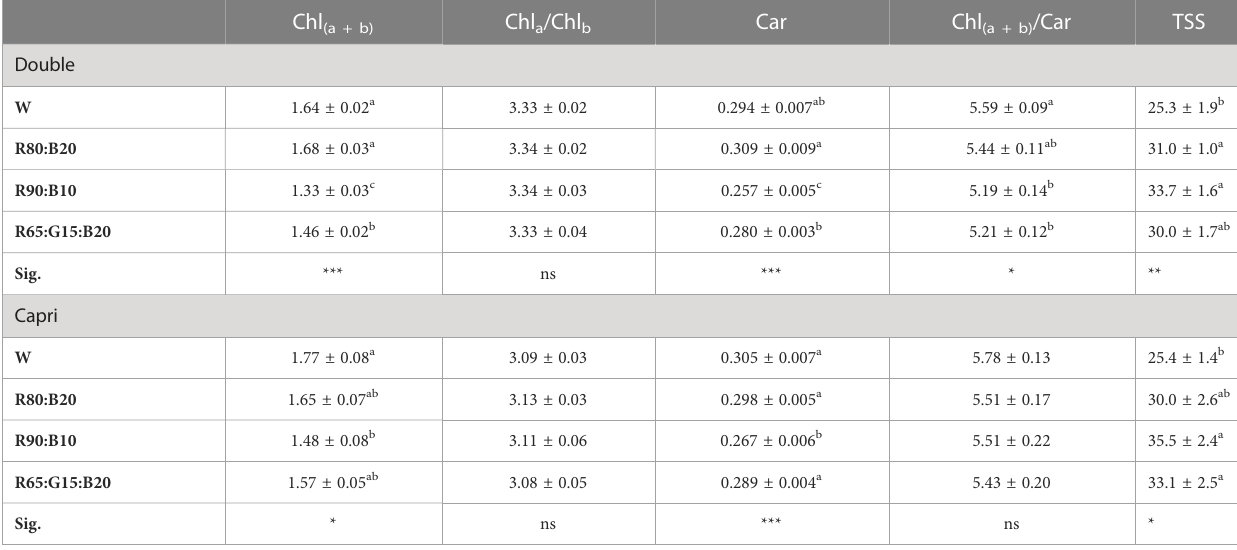
TABLE 4 Foliar photosynthetic pigments concentration (mg mg − 1 FW), total chlorophyll (Chl (a + b) ), chlorophyll a/b ratio (Chl a /Chl b ), total carotenoids (CAR) and Chl (a + b) /Car, and total soluble sugars concentration (TSS, mg g − 1 FW) of perennial ryegrass (cv. Double and Capri) under different LED illumination regimes at 400 m mol m − 2 s − 1 , 100% cool white (W), 80% Red:20% Blue (R80:B20), 90% Red:10% Blue (R90:B10) and 65% Red:15% Green:20% Blue